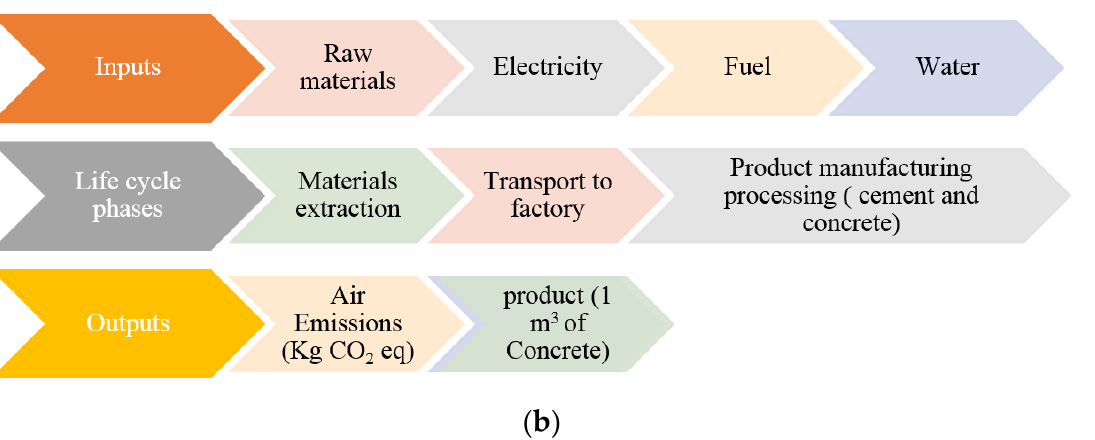
Figure 2. Phases of life cycle assessment. ( a ) Life cycle assessment framework. ( b ) Inputs and outputs in life cycle assessment.